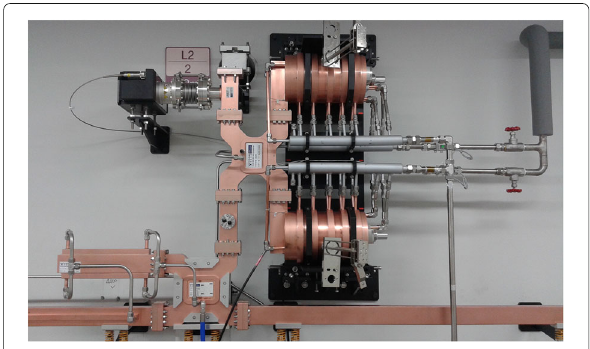
Fig. 5 The SLED for PAL-XFEL. The 3-dB power hybrid and two resonant cavities are shown